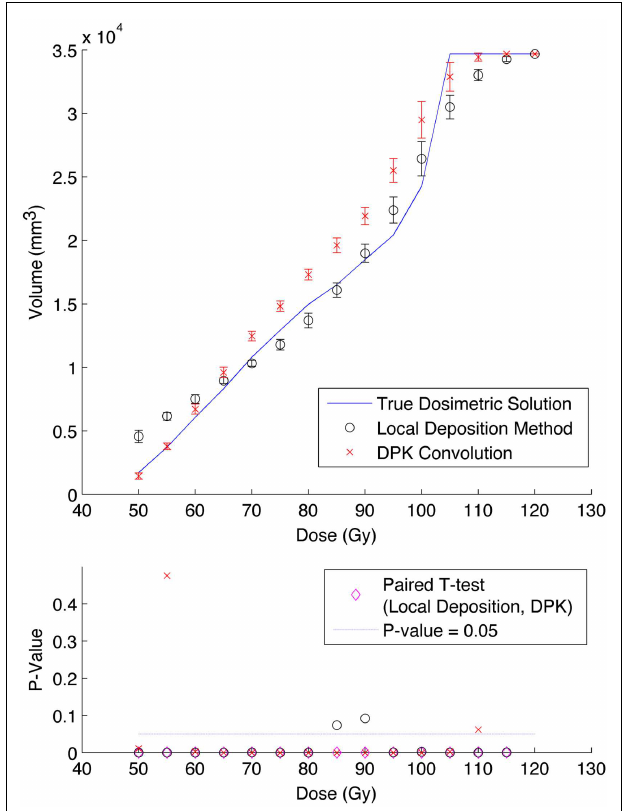
FIGURE 5 |Top: IDVH of NEMA phantom 17mm hot-sphere comparing DPK convolution and the local deposition method, as determined from 6, 40min scans according to recon 2 inTable 1 . Reconstruction was performed using 2mm isotropic voxels with 1 iteration, 21 subsets, and TOF. Both experimental IDVH are compared to the true dosimetric solution IDVH. Bottom: error